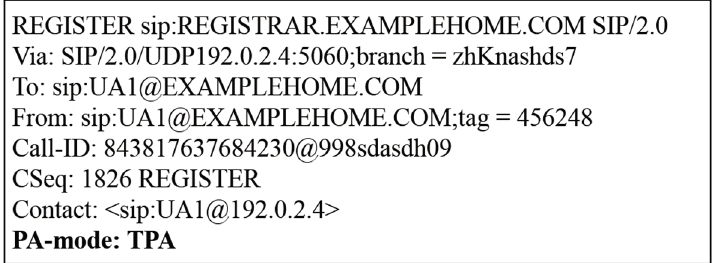
Figure 4. Extended header field “PA-mode”.